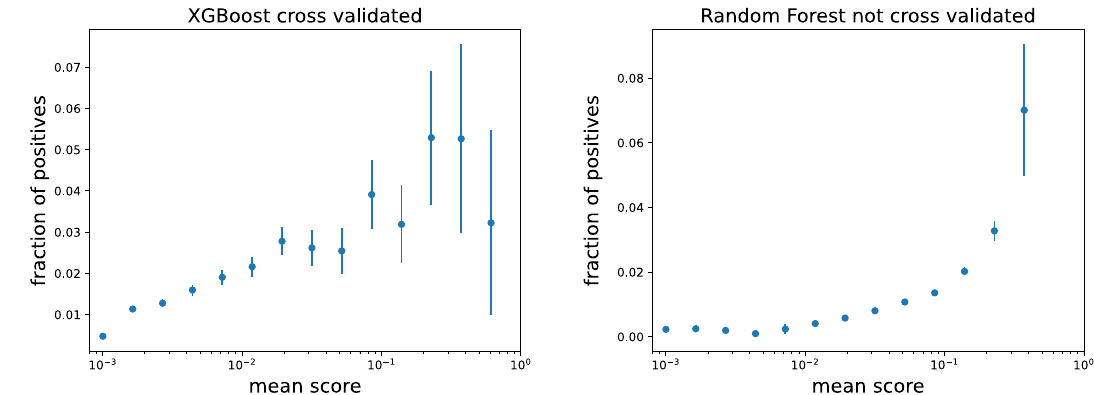
Figure 5. Calibration curves: fraction of positive elements as a function of the scores produced by XGBoost (left) and Random Forest (right) for the activations prediction task. In both cases a clear positive correlation is present, indicating that higher scores are associated to higher empirical probabilities that the activation will actually occur. Chromium wrought other than waste and scrap value = [1006, 86]